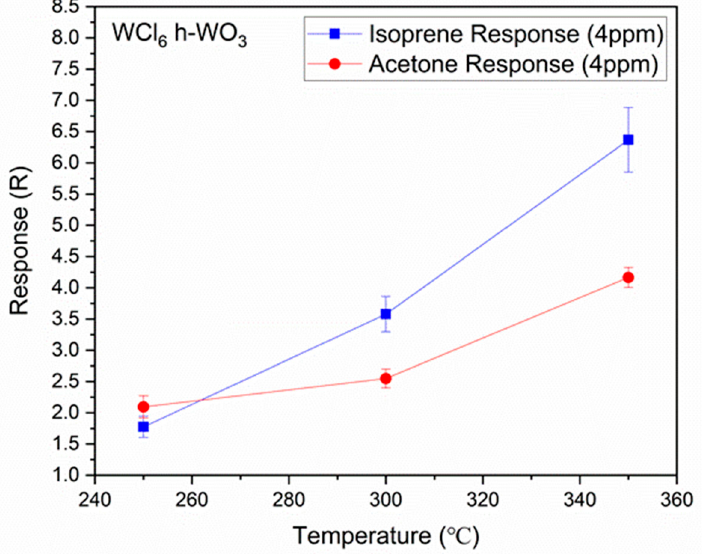
Figure 5. Comparison of the gas sensing response for the WCl 6 h - WO 3 nanstructured films from Figure 3 at 250, 300, and 350 ◦ C towards 4 ppm of acetone and isoprene along with their standard deviations.